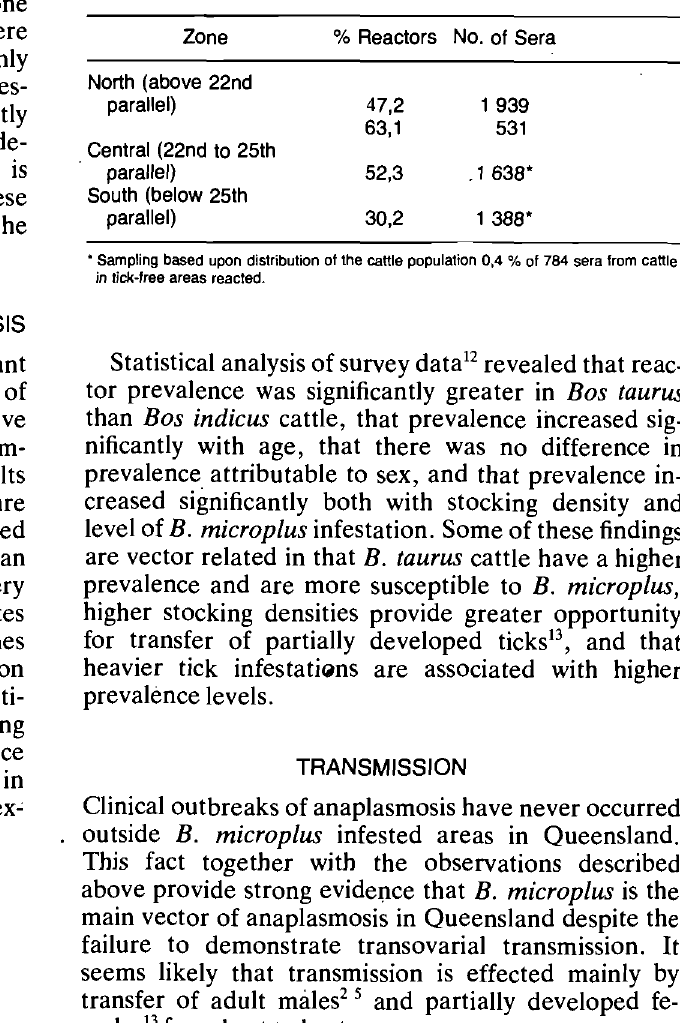
Table 2: PREVALENCE OF COMPLEMENT-FIXING ANTIBODIES IN CATTLE IN BOOPHILUS MICROPLUS INFESTED AREAS OF